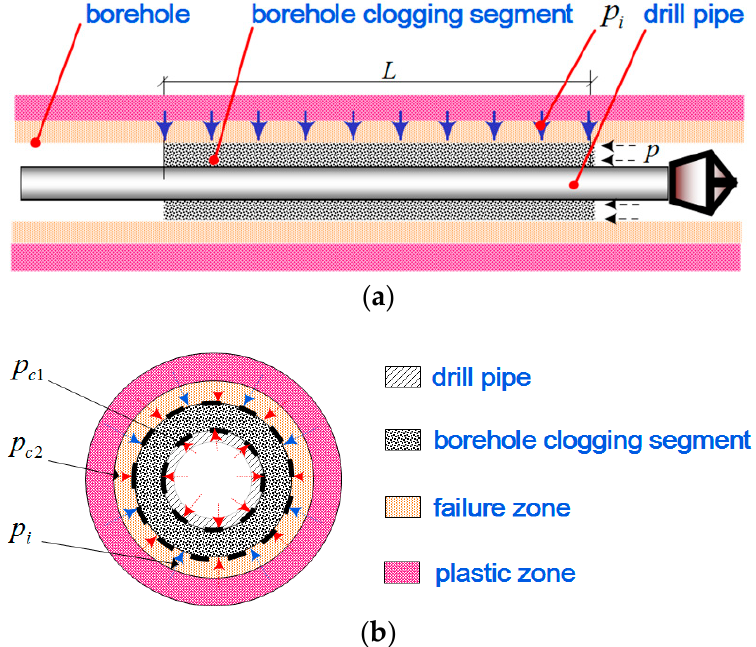
Figure 3. The stress state of the clogging segment: ( a ) borehole-axial section; and ( b ) borehole-cross-section.